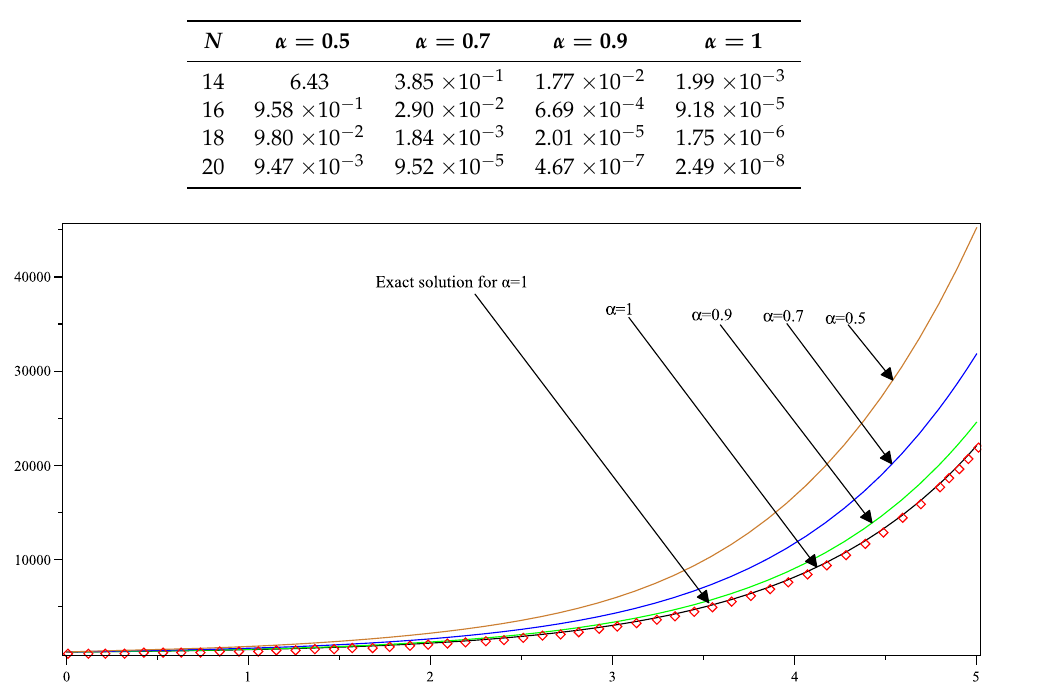
Table 5. The maximum absolute error with some N and various values of α by present method for Example 1.